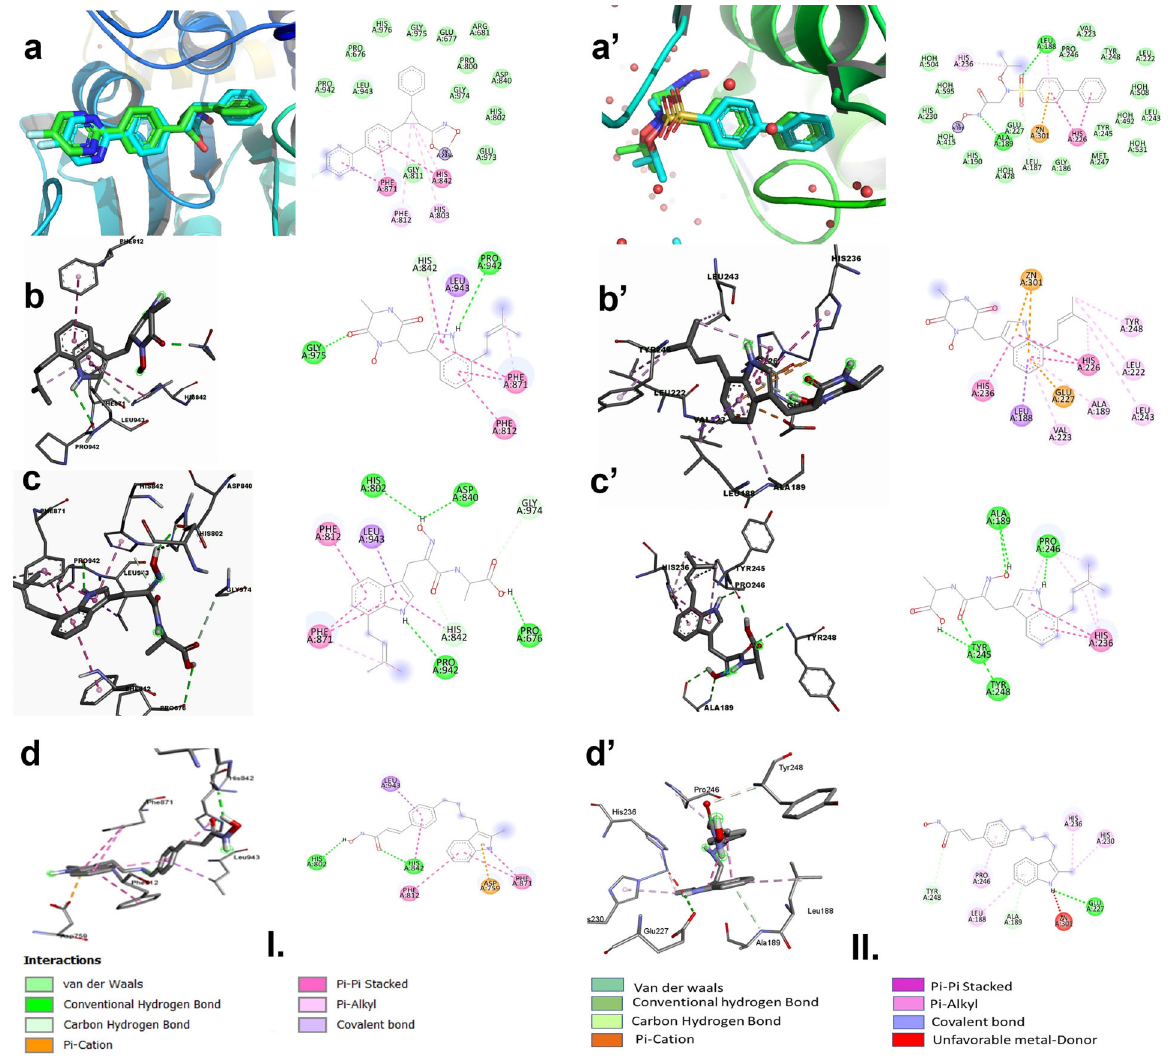
Figure 3. I : Docking results of our compounds against histone deacetylase (4CBT). a , Validation; crystal (green), docked (blue). b , Compound 1 docking pose and interactions. c , Compound 2 docking pose and interactions. d , Panobinostat docking pose and interactions. II : Docking results of our compounds against matrix metalloproteinase 9 (4H3X). a ’ , Validation; crystal (green), docked (blue). b ’ , Compound 1 docking pose and interactions. c ’ , Compound 2 docking pose and interactions. d ’ , Panobinostat docking pose and